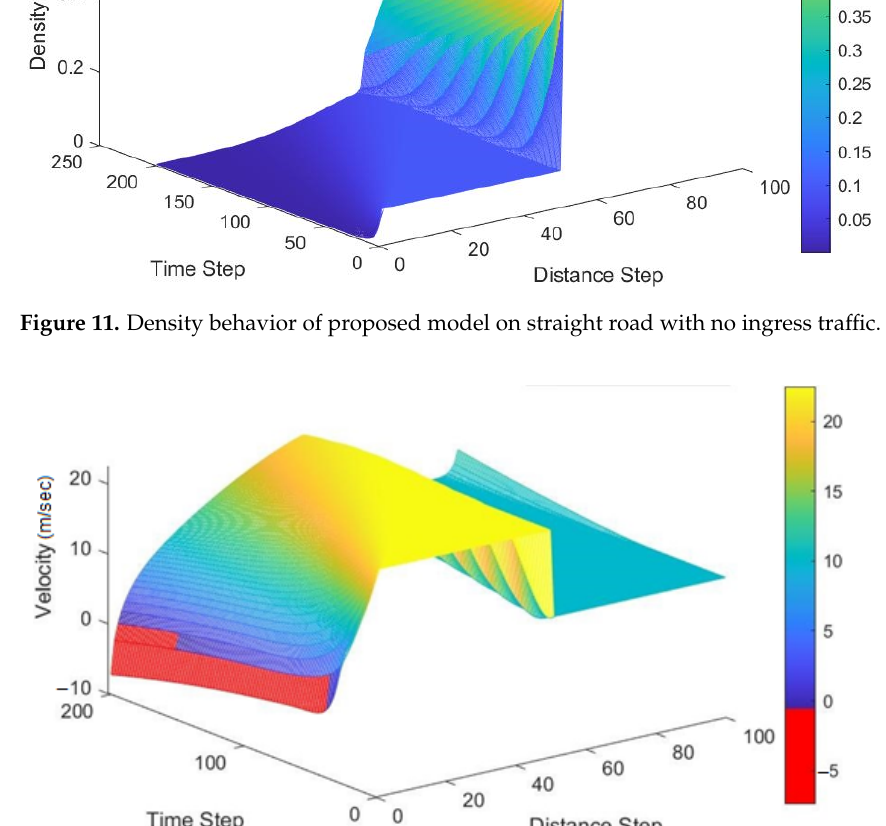
Figure 12. Velocity behavior of proposed model on straight road with no ingress traffic.